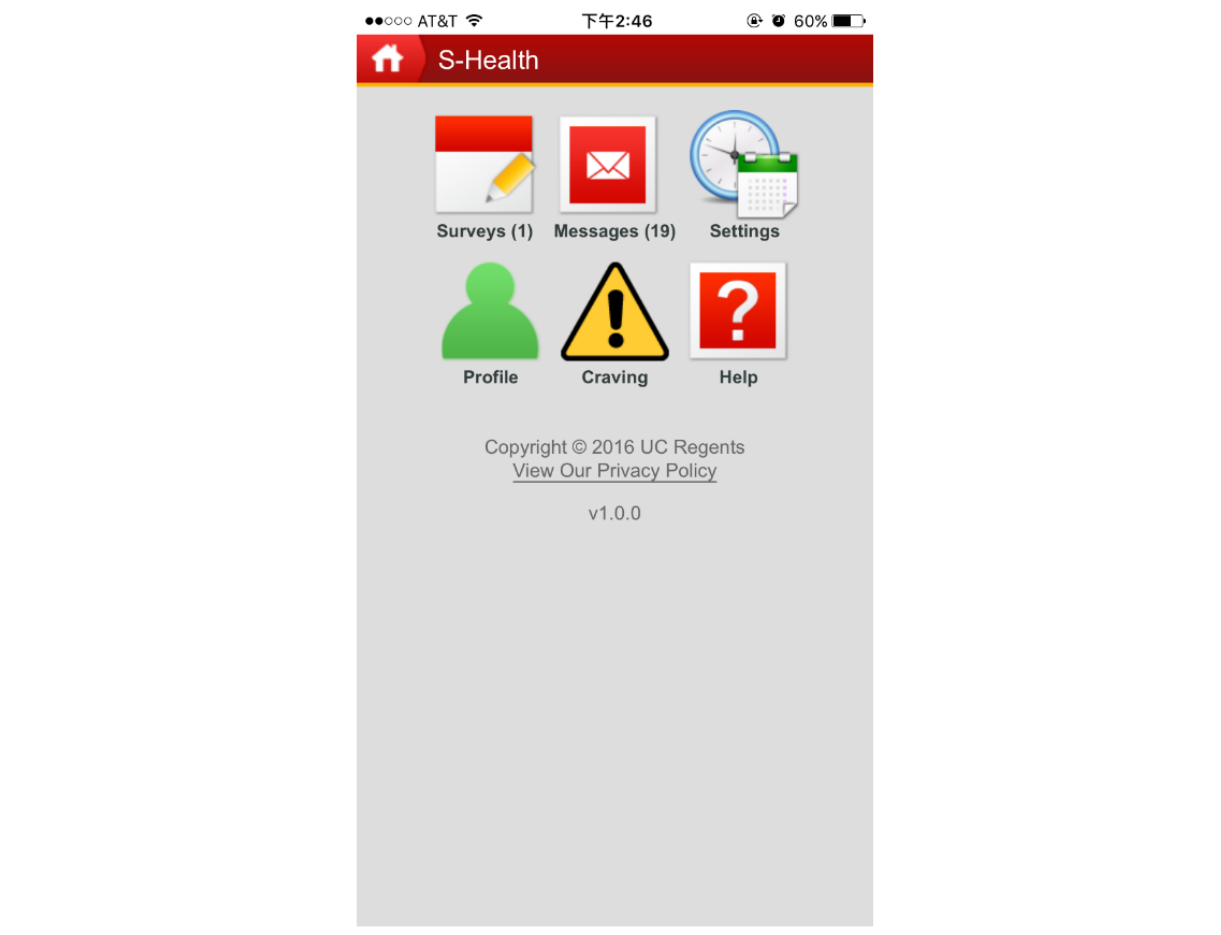
Figure 1. Home screen of the mobile health (mHealth)